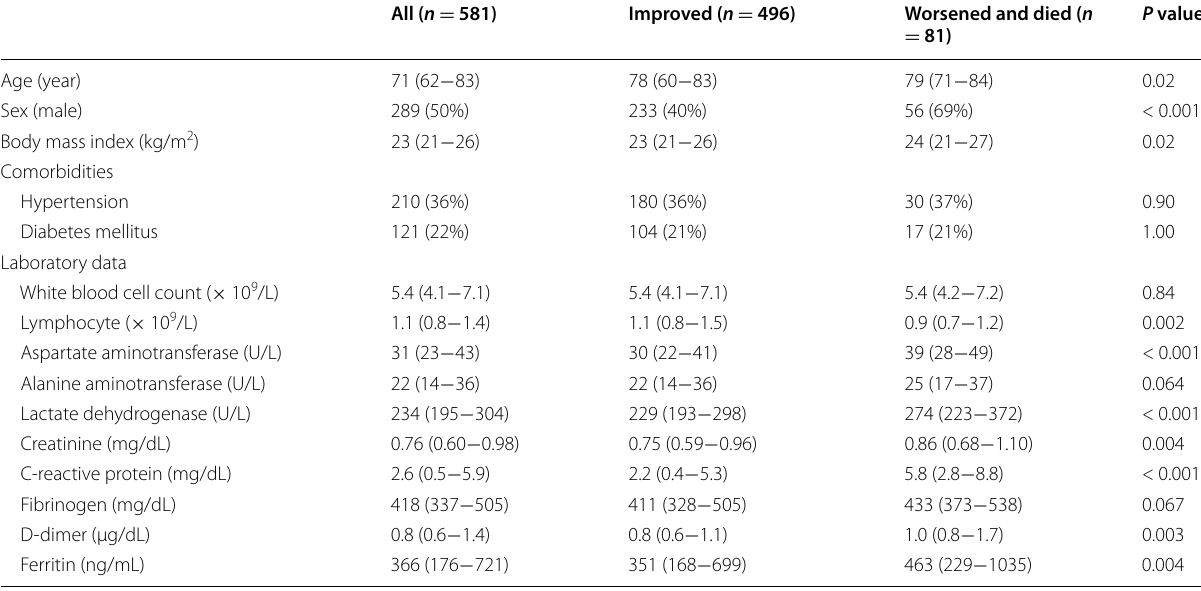
Table 4 Univariate analysis of characteristics, comorbidities, and laboratory data between patients with recovered and worsened respiratory condition